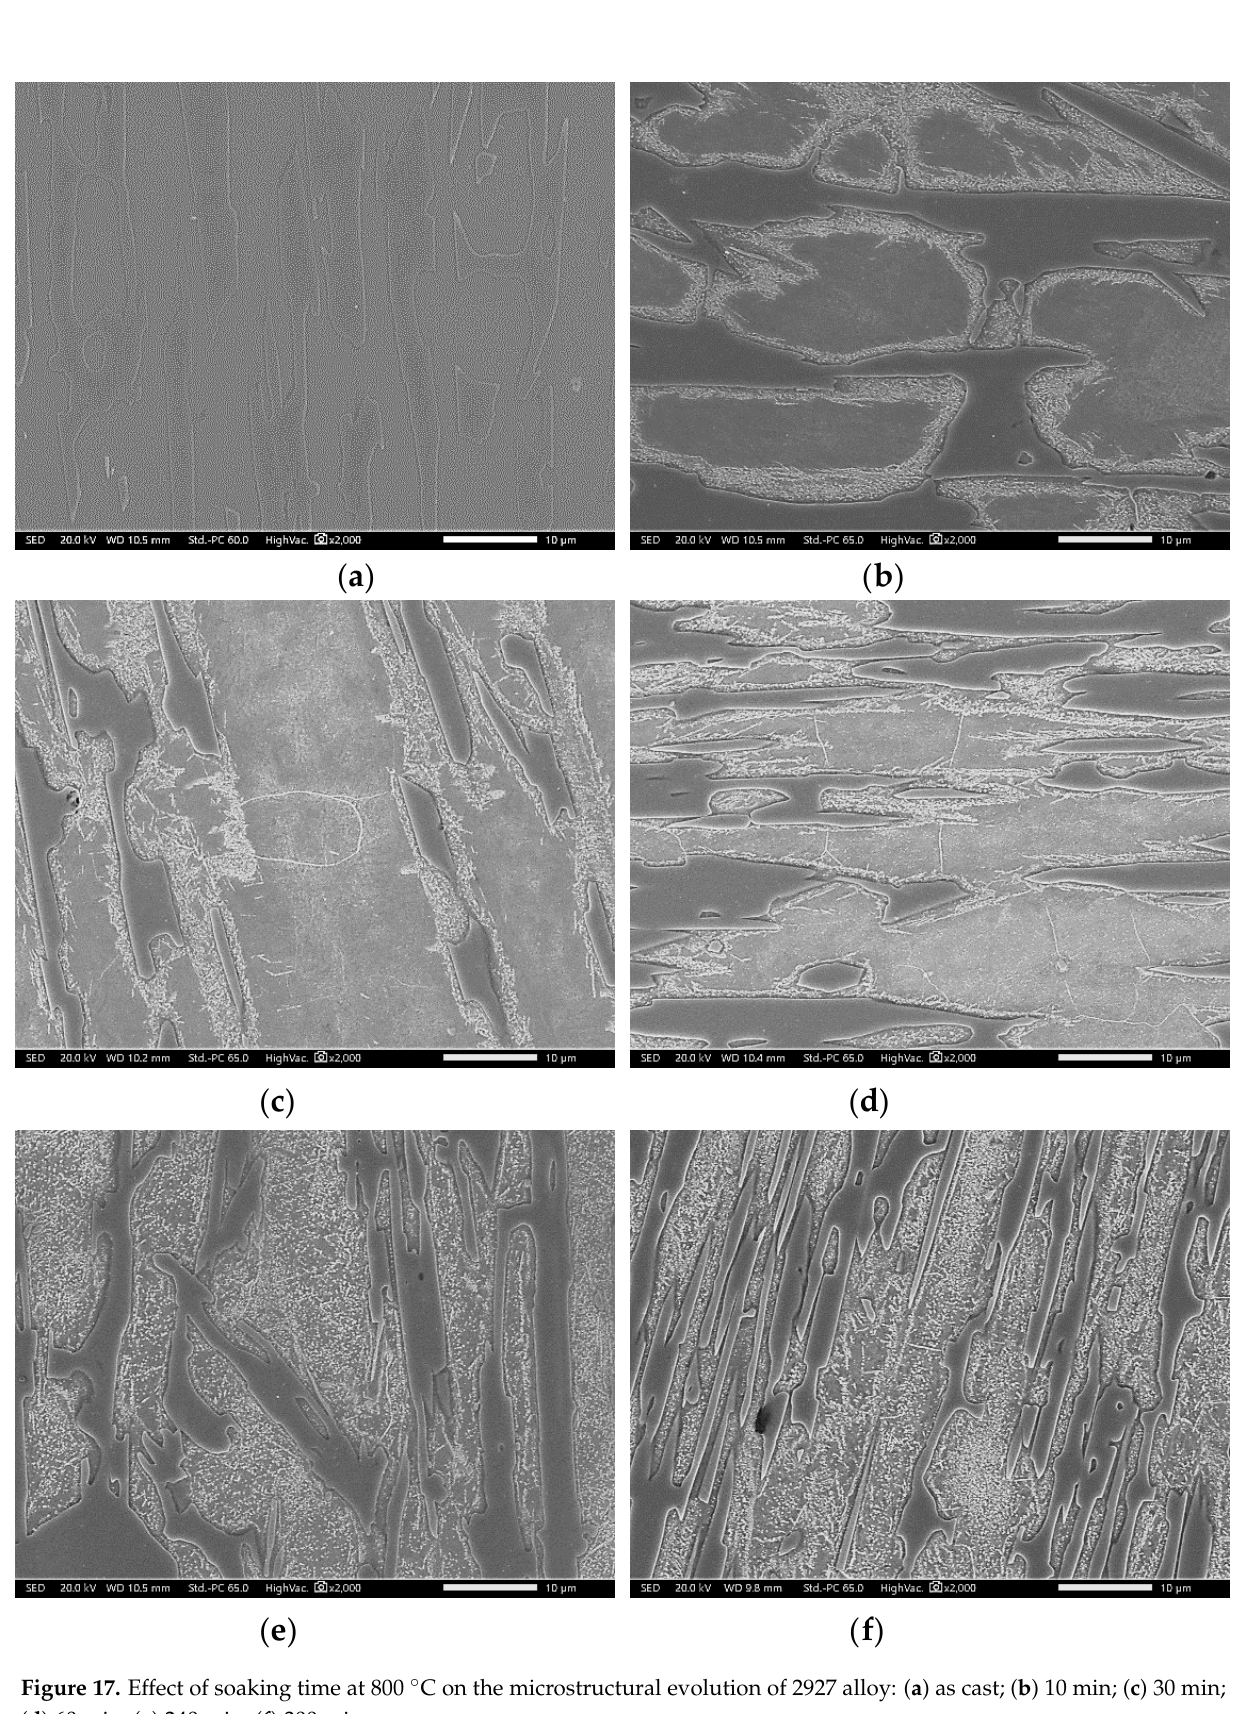
Figure 17. Effect of soaking time at 800 °C on the microstructural evolution of 2927 alloy: ( a ) as cast; ( b ) 10 min; ( c ) 30 min; ( d ) 60 min; ( e ) 240 min; ( f ) 300 min.